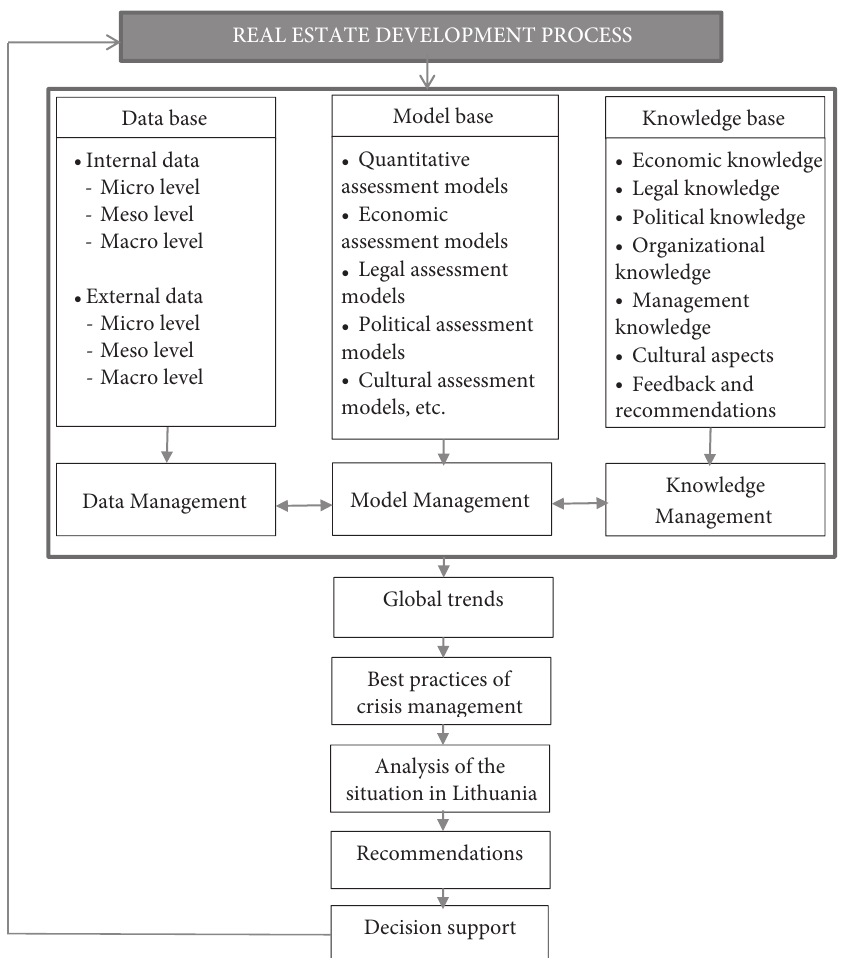
Figure 2. Decision support model for real estate